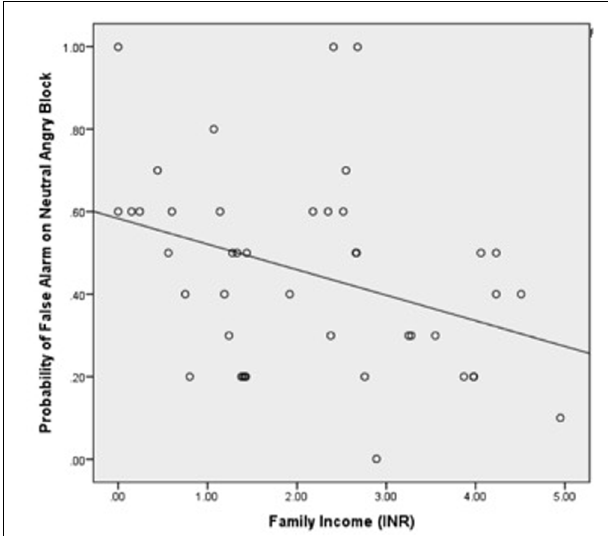
FIGURE 2 | Relationship between family income and the probability of false alarm rates during Angry “NoGo” distracter trials, b = − 0.36, p < 0.05.